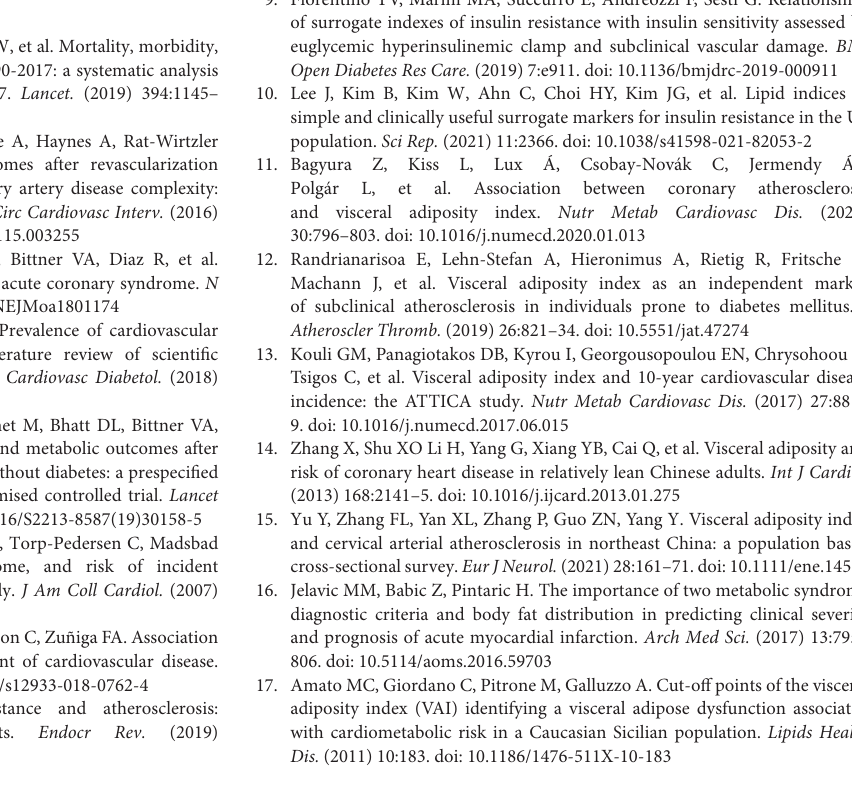
Supplementary Figure 1 | Flow diagram for the enrollment of study population. NSTE-ACS, non-ST-segment elevation acute coronary syndrome; PCI, percutaneous coronary intervention; T1DM, type 1 diabetes mellitus; CABG, coronary artery bypass grafting; TG, triglyceride; eGFR, estimated glomerular filtration rate; ALT, alanine transaminase; AST, aspartate transaminase; URL, upper reference limit; BMI, body mass index; MI, myocardial infarction. Supplementary Table 1 | Incidence of primary endpoint and each component according to the median of VAI. MI, myocardial infarction; VAI, visceral adiposity index. Supplementary Table 2 | Unadjusted Cox regression analysis investigating predictors of primary endpoint. BMI, body mass index; WC, waist circumference; SBP, systolic blood pressure; DBP, diastolic blood pressure; CAD, coronary artery disease; MI, myocardial infarction; PCI, percutaneous coronary intervention;